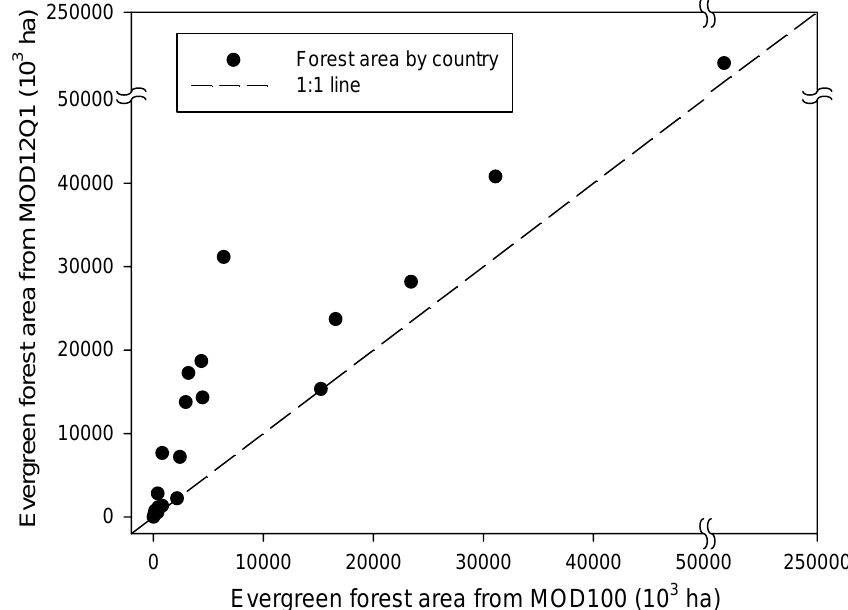
Figure 7. A country-level comparison for the area estimates of evergreen forests in tropical Asia between the LSWI-based algorithm in this study (MOD100) and the standard MODIS Land Cover Product (MOD12Q1) in